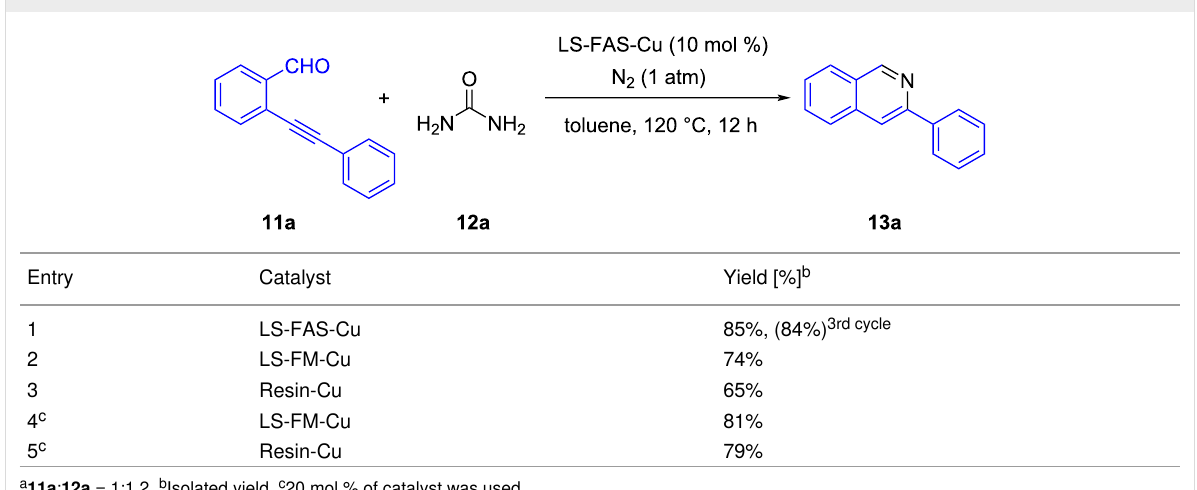
Table 6: Synthesis of the 3-phenylisoquinoline from 11a and urea ( 12a ). a